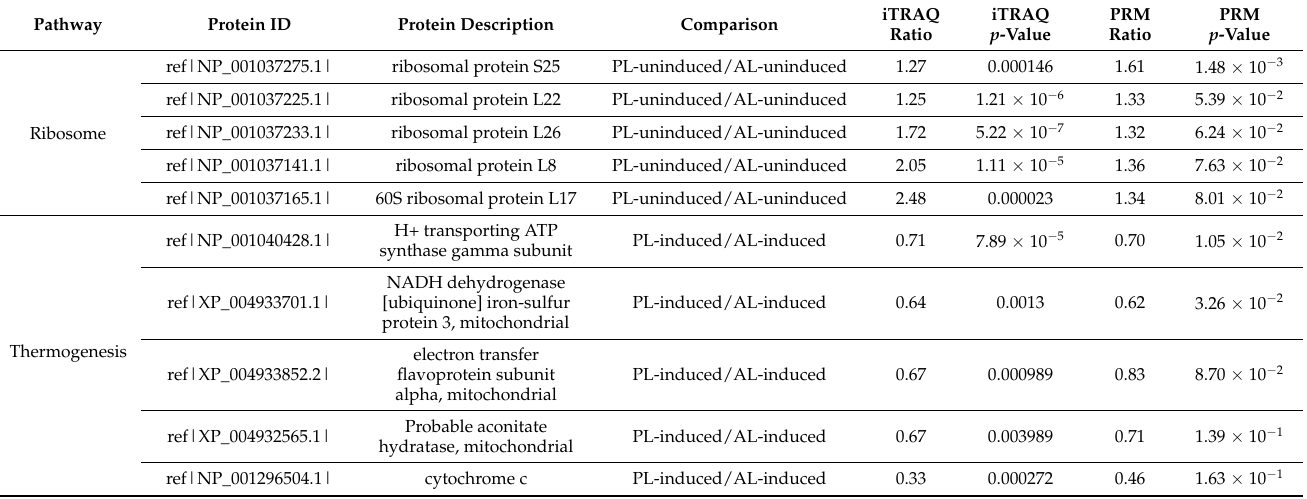
Figure 7. Profile patterns of differential abundance proteins (DAPs) selected from the most enriched pathway before and after thermal induction using parallel reaction monitoring (PRM) validation. Dotted lines at 0.27 represents 1.2-fold (for increased abundance) and − 0.27 represents 0.83-fold (for decreased abundance). Table 5. Validation of differential abundance proteins (DAPs) with parallel reaction monitoring (PRM